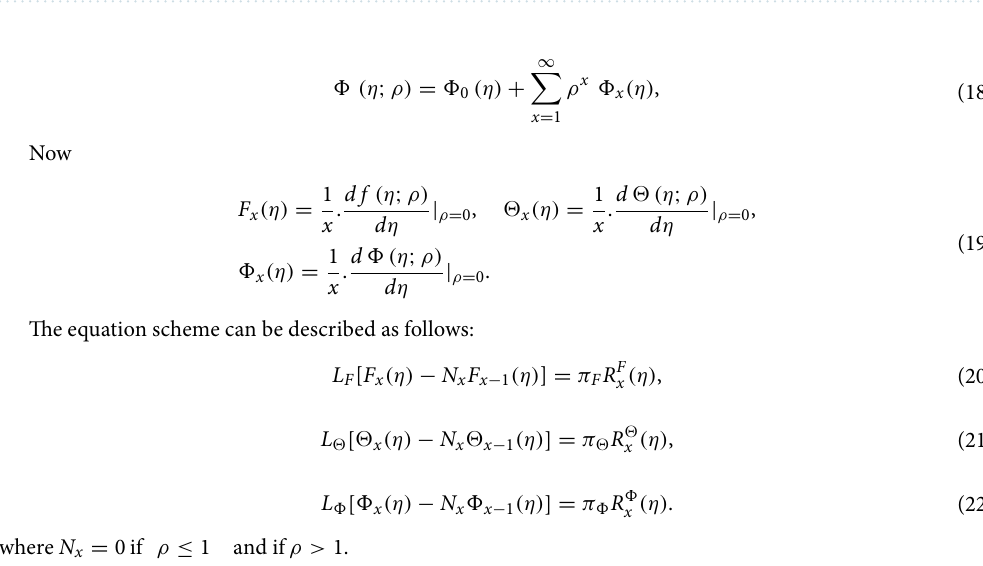
Figure 2. Alterations in F ′ (η) as M raises. When S = 0.1, Pr = 6.2, Gr = Gc = 0.2, Ec = 1, Nb = Nt = 0.3, Sc = 0.3